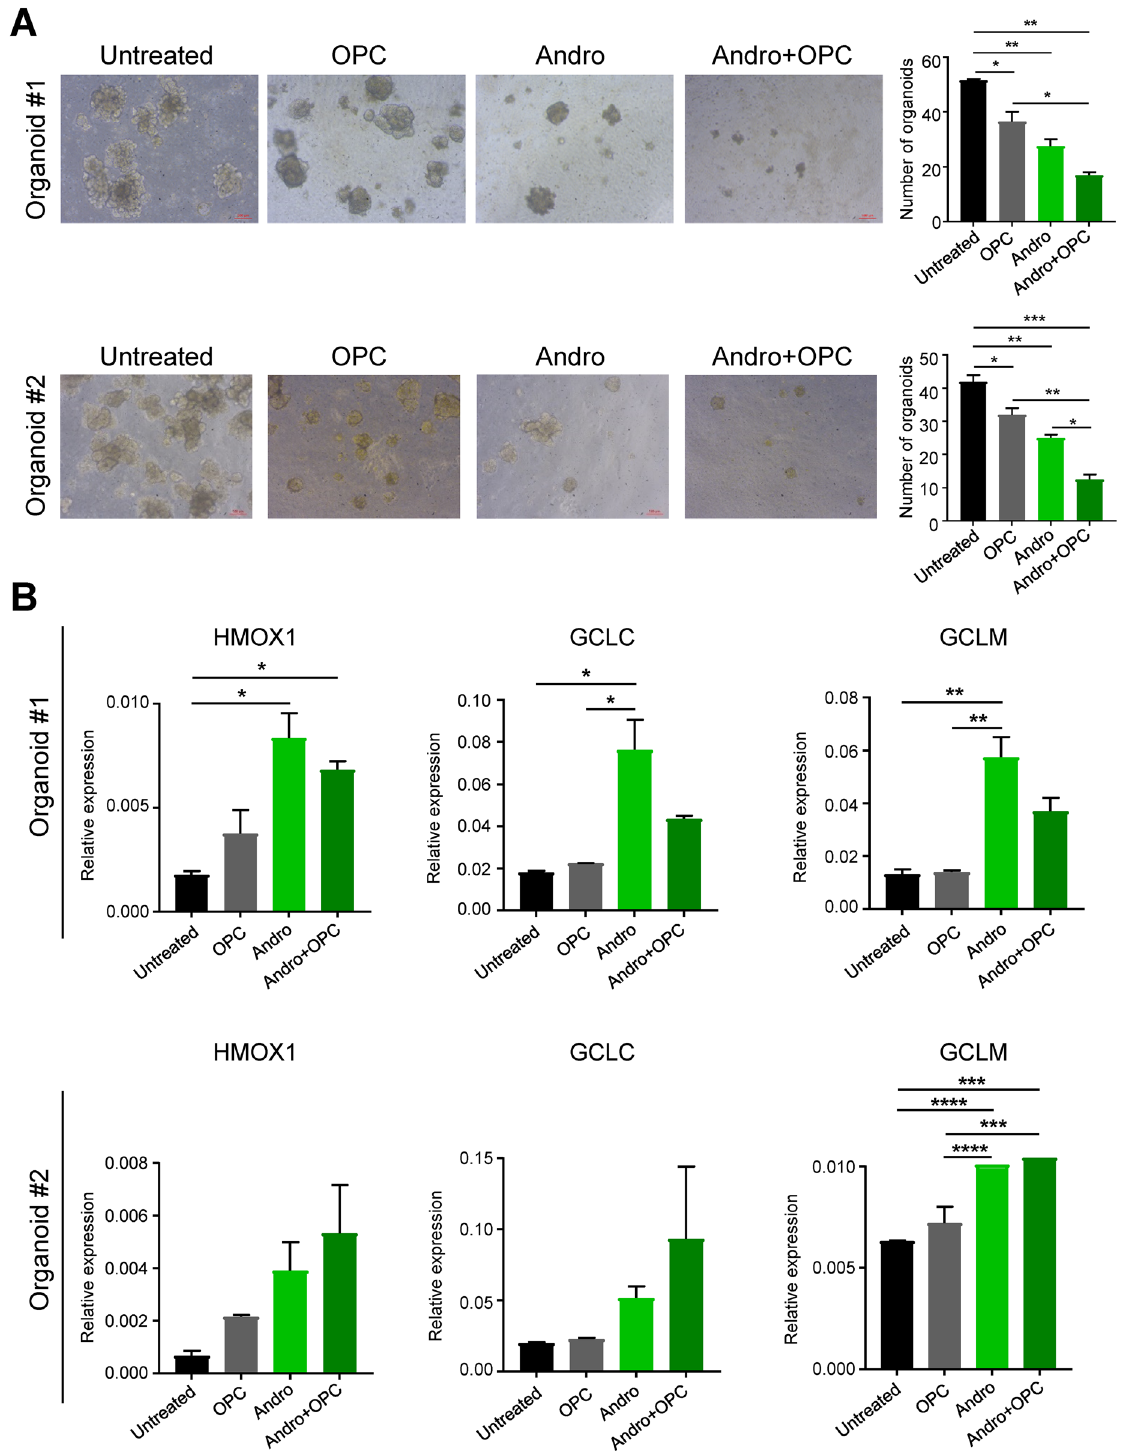
Figure 6. Andrographis and combination treatment with OPCs enhanced tumor growth suppression of organoids derived from human colorectal tumors. ( A ) Representative images of tumor organoid cultures in each treatment group and the bar graphs showing the number of organoids in each treatment group. ( B ) Bar graphs illustrate mRNA expression of ferroptosis-related genes (HMOX1, GCLC, and GCLM) of each treatment group in CRC tumor organoid derived from two different patients. Statistical Significance is as follows: *P < 0.05, **P < 0.01, ***P < 0.001, and ****P < 0.0001 by one-way ANOVA